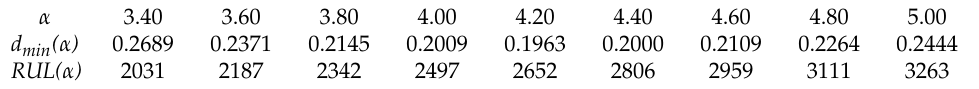
Table 4. Similarity evaluation for RUL estimation of Bearing1-6 using Bearing1-2.